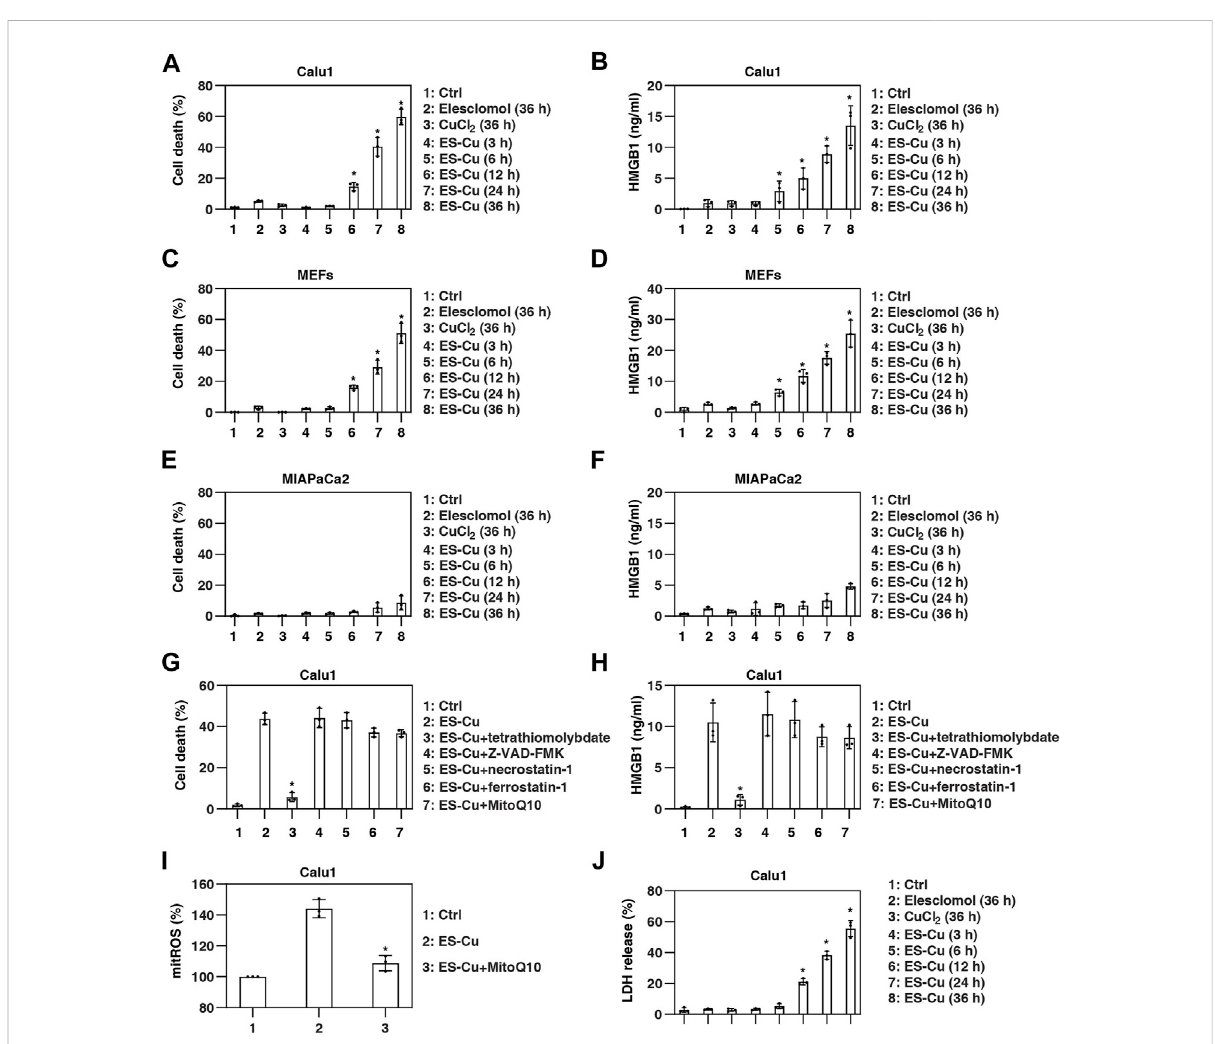
FIGURE 1 HMGB1 is released during cuproptosis. (A – F) Indicated cells were treated with elesclomol (30 nM), CuCl 2 (30 nM), or elesclomol + CuCl 2 (ES- Cu)for3 – 36 handthencelldeathandHMGB1releasewereassayed( n =3;* p < 0.05versuscontrolgroup, one-way ANOVA).(G,H)Calu1cellswere treated with ES-Cu (30 nM/30 nM) in the absence or presence of tetrathiomolybdate (20 µM), Z-VAD-FMK (20 µM), necrostatin-1 (20 µM), ferrostatin-1 (1 µM), or MitoQ10 (5 µM) for 24 h. Cell death and HMGB1 release were assayed ( n = 3; * p < 0.05 versus ES-Cu group, t test). (I) Effects of MitoQ10 (5 µM) on mitoROS production in Calu1 cells following treatmentwith ES-Cu (30 nM/30 nM) for 24 h ( n = 3; * p < 0.05 versus ES- Cugroup, t test).(J)Calu1cellsweretreatedwithelesclomol(30 nM),CuCl 2 (30 nM),orelesclomol+CuCl 2 (ES-Cu)for3 – 36 handthenLDHrelease were assayed ( n = 3; * p < 0.05 versus control group, one-way ANOVA). The results in (A – J) are representative of those from three independent